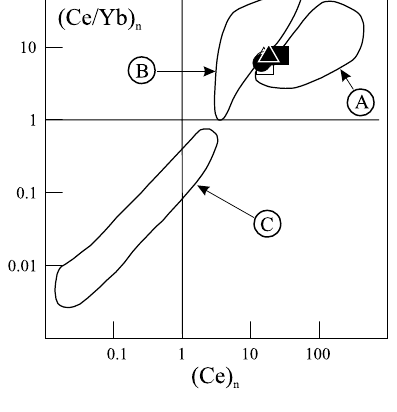
Fig. 12 – (Ce/Yb) n vs. Ce n diagram for clinopyroxenes from the Janjão, Pandolfo and Lambedor diatremes. A) field of clinopyroxenes of peridotitic xenoliths from alkali basalts after Wang and Gasparik (2001); B) field of clinopyroxenes of peridotitic xenoliths from kim- berlites after Wang and Gasparik (2001) and Grégoire et al. (2003); C) field of clinopyroxenes from abyssal peridotites after Johnson et al. (1990). Symbols as in Fig.